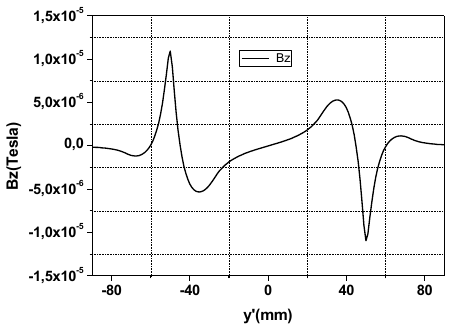
Figure 7: Computed values of 𝐵 for a sane plate for ! 𝑦 = 0 at a distance of 𝑑 = 1 . 5 𝑚𝑚 from the top Figure 9: Same as figure 7, but with a crack width equal surface of the plate to 1mm ; (A) depth = 0 . 5mm ; (B) depth = 1mm